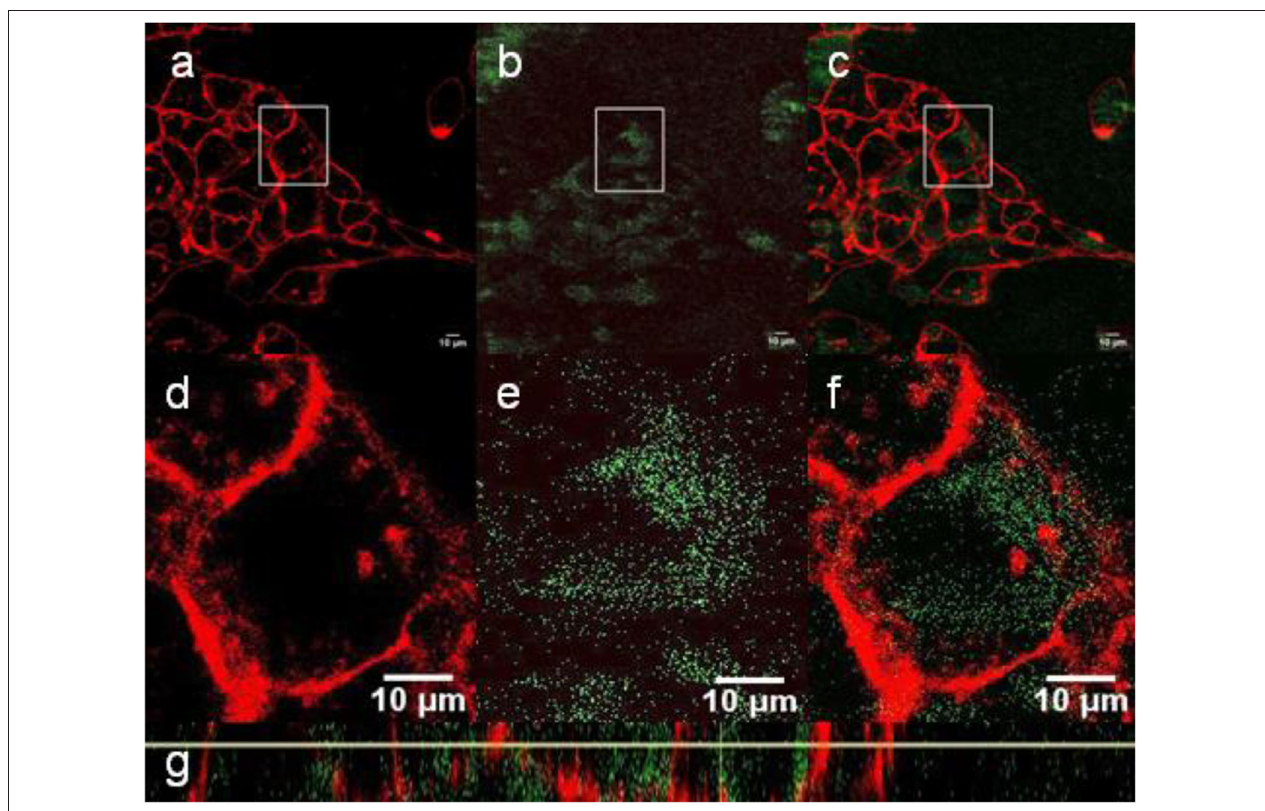
FIGURE 7 | (a–f) Confocal micrographs showing the distribution of NaYF 4 :Yb 3 + /Er 3 + @NaYF 4 :Nd 3 + nanoparticles (200 µ l) in Hep-G2 cells at 980nm excitation with a laser power of 30–50 mW. (d–f) Detailed micrographs of (a–c) . (a,d) CellMask TM deep red cell-stained cell membrane, (b,e) nanoparticles (green), and (c,f) overlay of (a,b,d,e) . (g) The xz-plane of NaYF 4 :Yb 3 + /Er 3 + @NaYF 4 :Nd 3 + nanoparticle-labeled Hep-G2